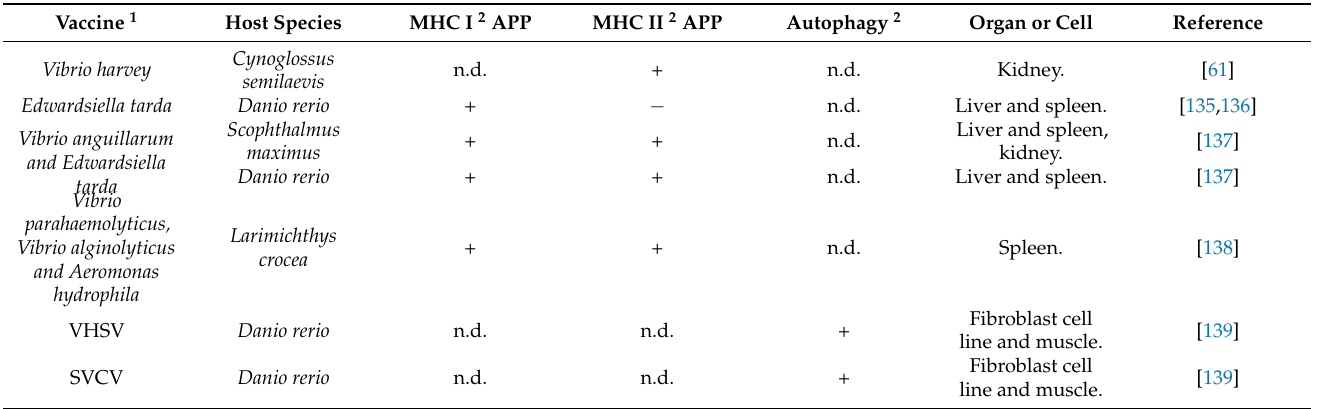
Table 3. Modulation of expression of genes involved in antigen processing and presentation (APP) MHC class I and II pathways and autophagy during vaccination of teleost fish